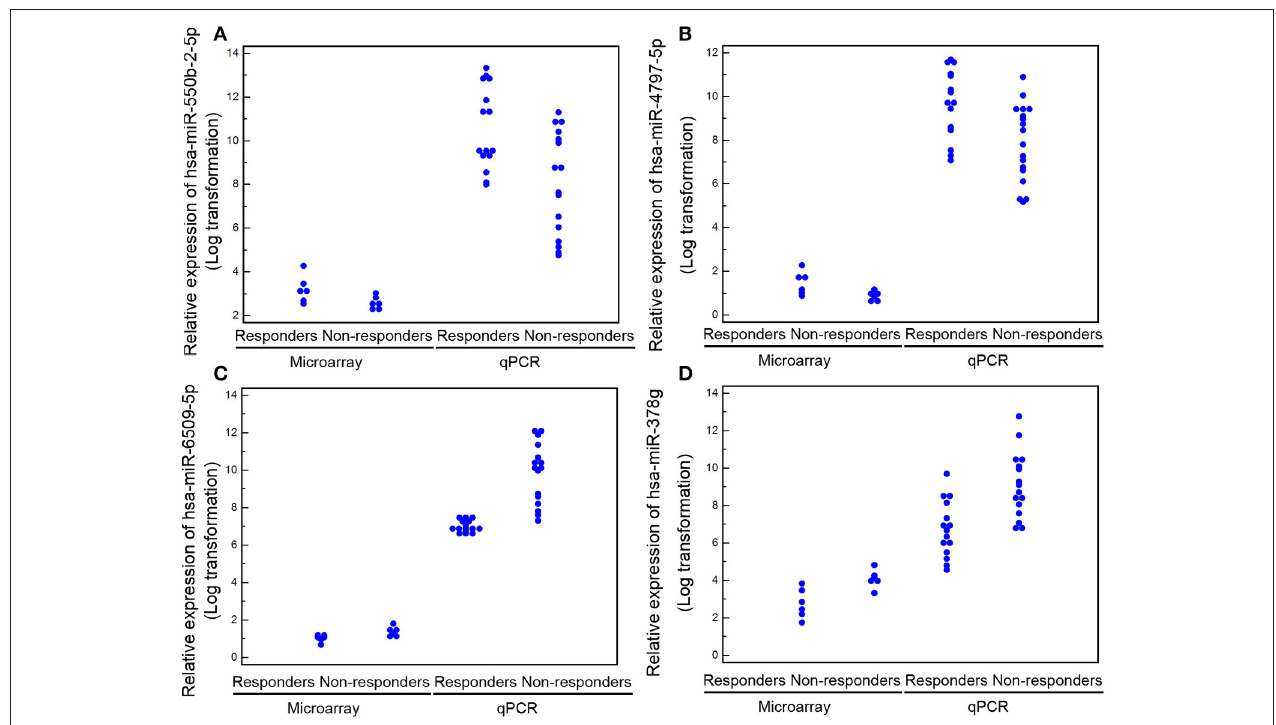
FIGURE 4 | Levels of the four candidate miRNA biomarkers (A) for hsa-miR-550b-2-5p; (B) for hsa-miR-4797-5p; (C) for hsa-miR-6509-5p; (D) for hsa-miR-378g) in peripheral blood detected by microarray and quantitative PCR analyses . Data are represented as the mean ± S.D. ( n = 6 for each group in the discovery cohort; n = 16 and 15 for non-responder and responder groups in the validation cohort).